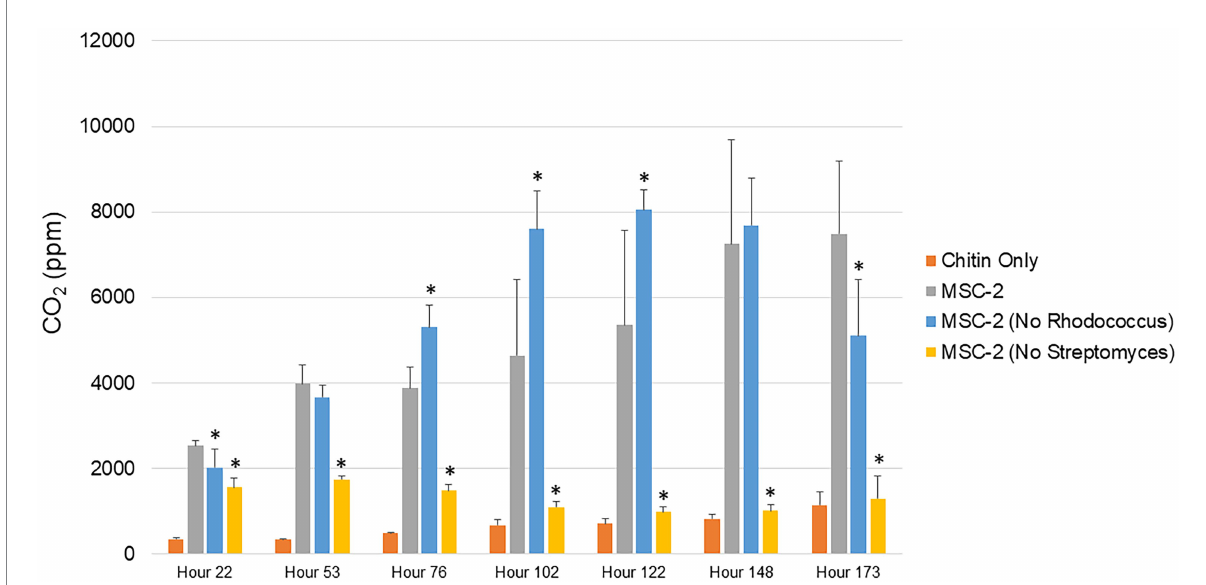
FIGURE 1 Respiration of MSC-2 and MSC-2 subset communities during chitin growth. CO 2 levels in parts per million are shown on the y-axis and timepoints ranging from 22 to 173 h are shown on the x-axis. Orange bars are uninoculated samples containing only chitin, grey bars are complete MSC-2 communities, blue bars are MSC-2-R communities (lacking Rhodococcus ), and yellow bars are MSC-2-S communities (lacing Streptomyces ). Error bars indicate standard deviation and asterisks indicate that the community is statistically different from the MSC-2 community at that timepoint with a p -value of less than 0.05 using a Students t